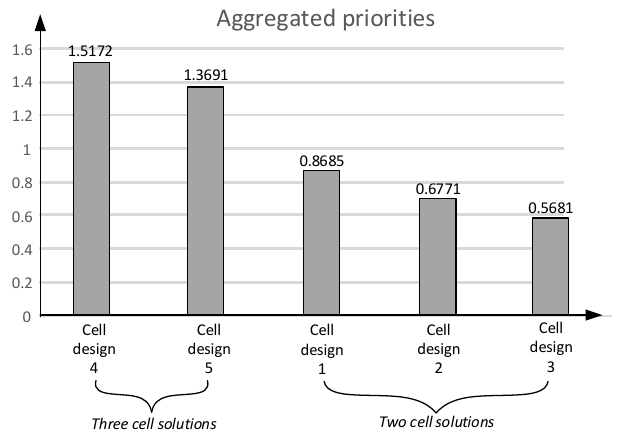
Figure 8. Final comparison of cell designs.